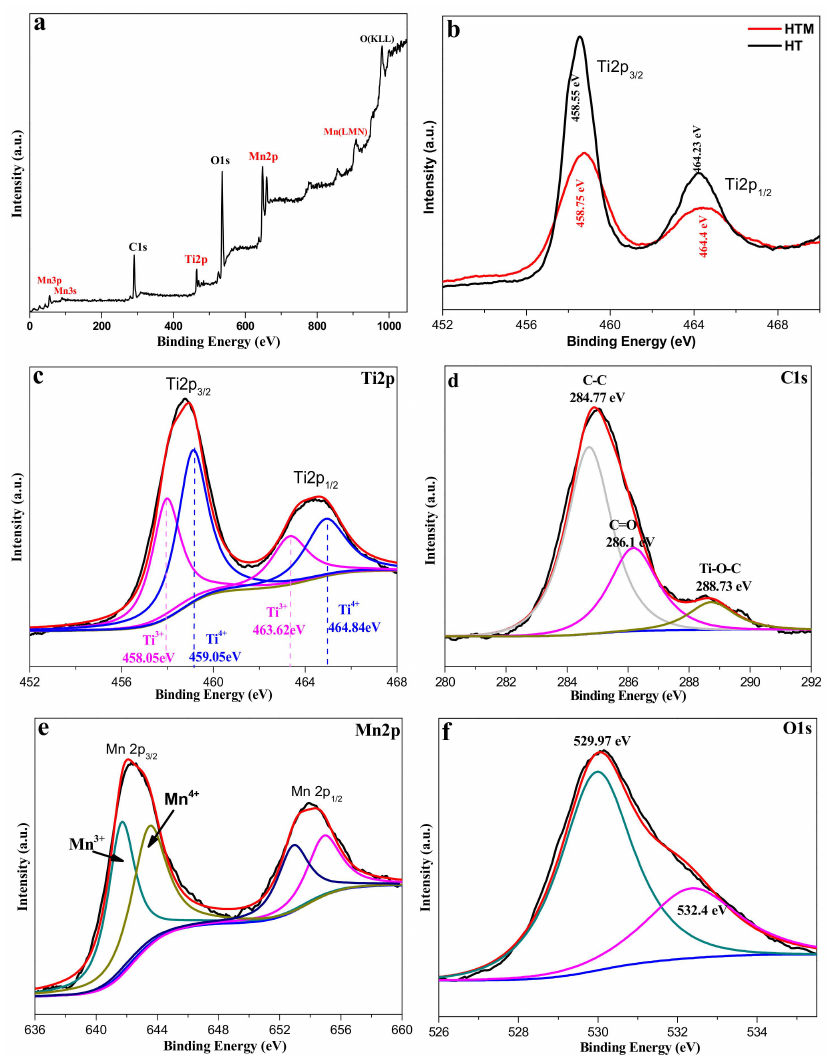
Figure 5. XPS fully scanned spectrum of HTM ( a ), XPS spectra of Ti2p ( b ), Ti2p Gaussian peaks ( c ), C1s ( d ), O1s ( e ), Mn2p ( f